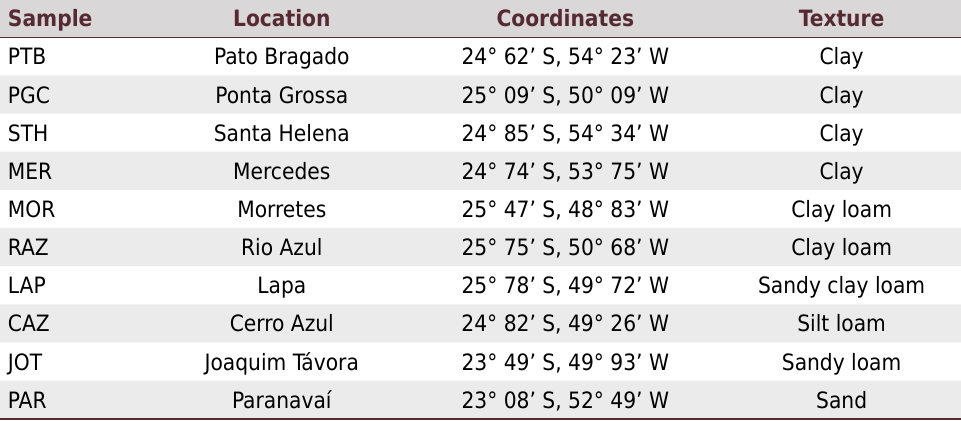
Table 1. Information of the soil samples studied